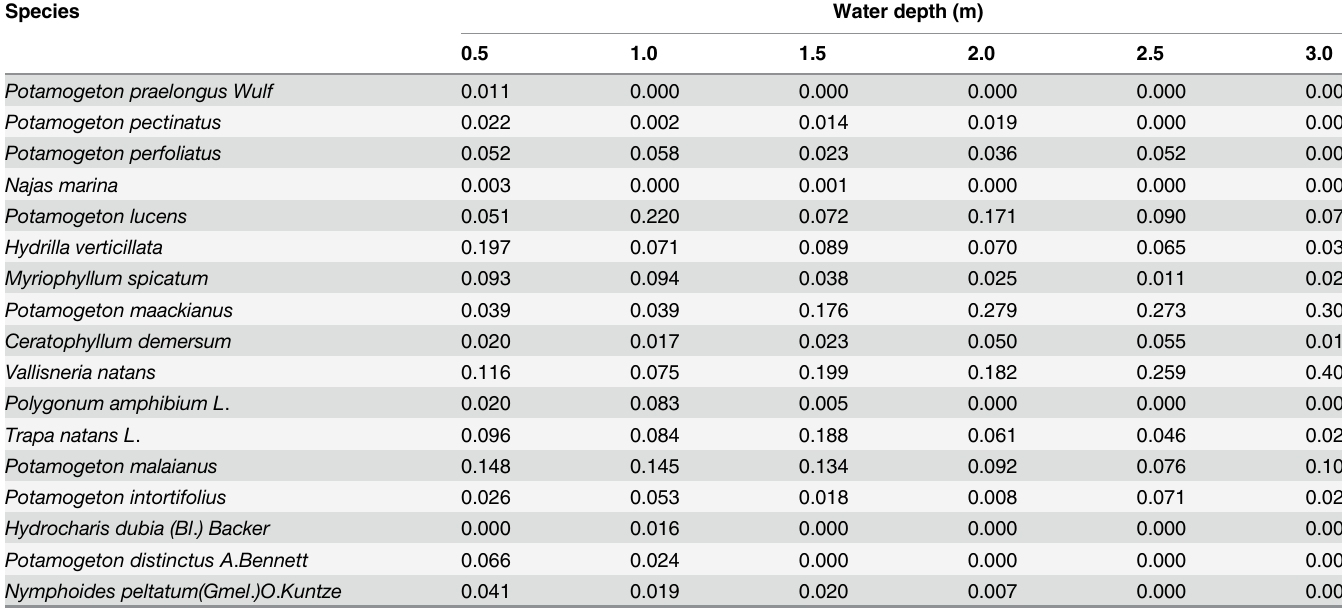
Table 1. The mean abundance (kg dry weight m -2 ) of 17 macrophyte species across the water depth